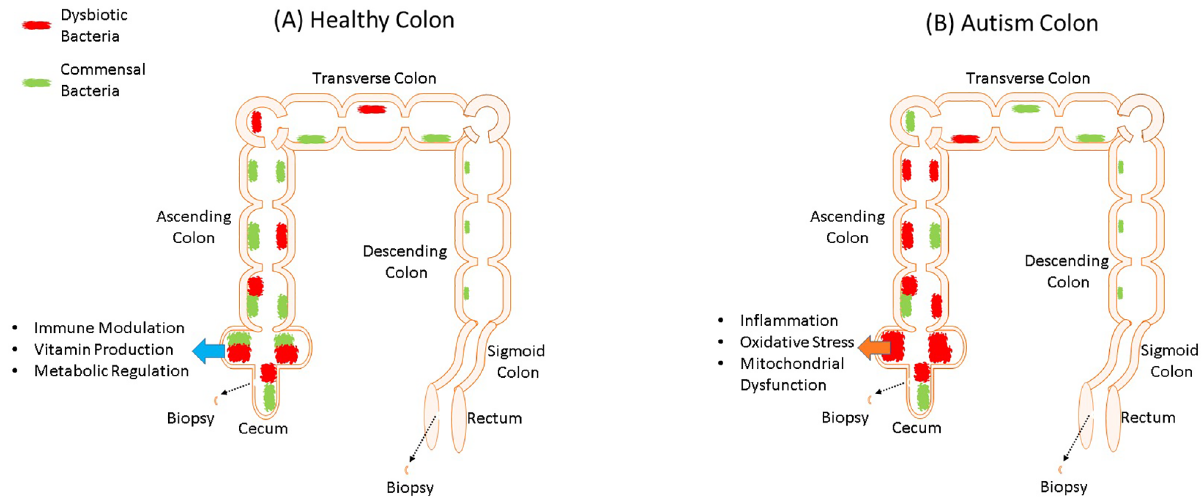
Fig 2. The microbiome in the lower gastrointestinal (GI) tract of healthy (A) and individuals with autism (B). (For review of difference in the microbiomebetweenchildrenwith autism and neurotypical childrenplease see our recent reviews [35, 36]). For both neurotypical and autistic children,we obtainedbiopsy samples from the cecum and rectum. It is believedthat the GI tract of individualswith autism have a greater amount of dysbioticbacteria as comparedto commensalbacterial. While the microbiomeof the healthy GI tract provides positive immune and metabolicregulation,the imbalance in bacteria in the GI tract of individuals with autism results in oxidativestress, inflammation and mitochondrial dysfunction. Since the cecum is one of the most metabolically active regions of the GI tract for the microbiome, we are particularlyinterested in measuringmitochondrial function in the cecum. We comparedmitochondrial function in the cecum to the rectum since the rectum has a much less metabolically activity microbiome. To understandif mitochondrial abnormalities are uniqueto childrenwith ASD, we comparedmeasurement of mitochondrial function in childrenwith ASD to two groups of childrenwithout ASD, those with Crohn’s disease and those with non-specific GI complaints.